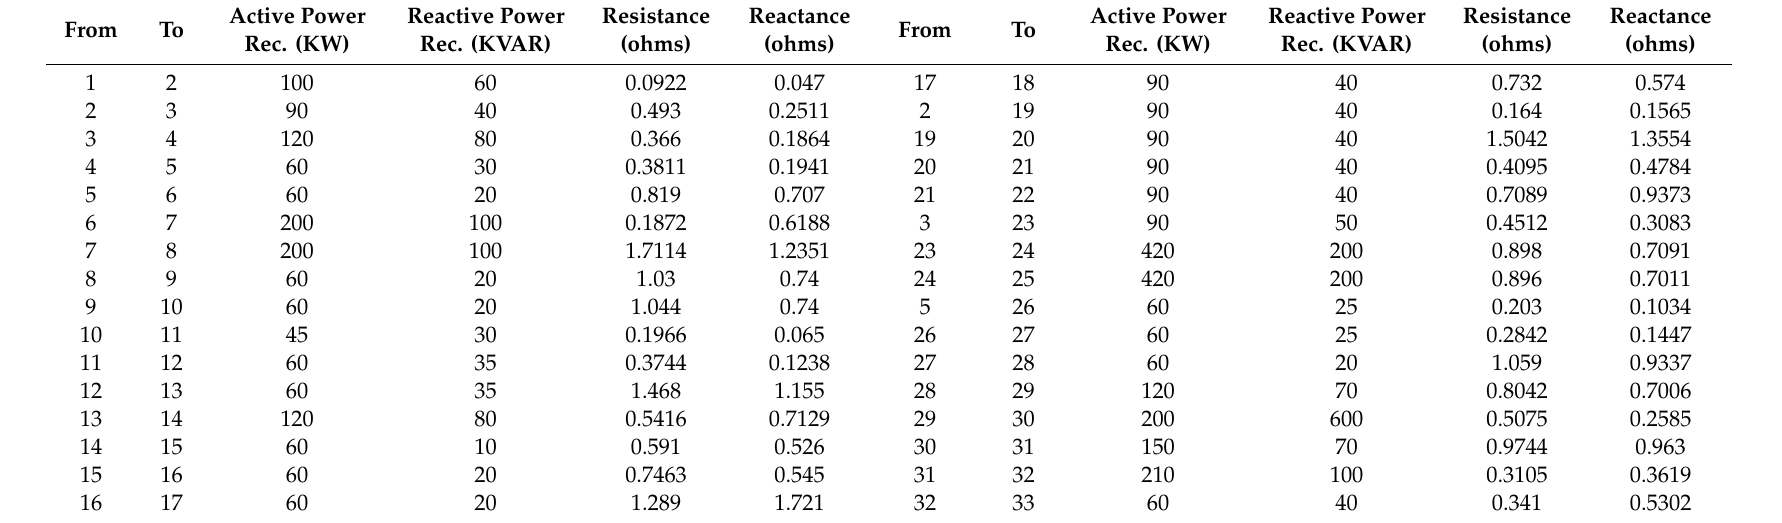
Table 1. IEEE-33 bus